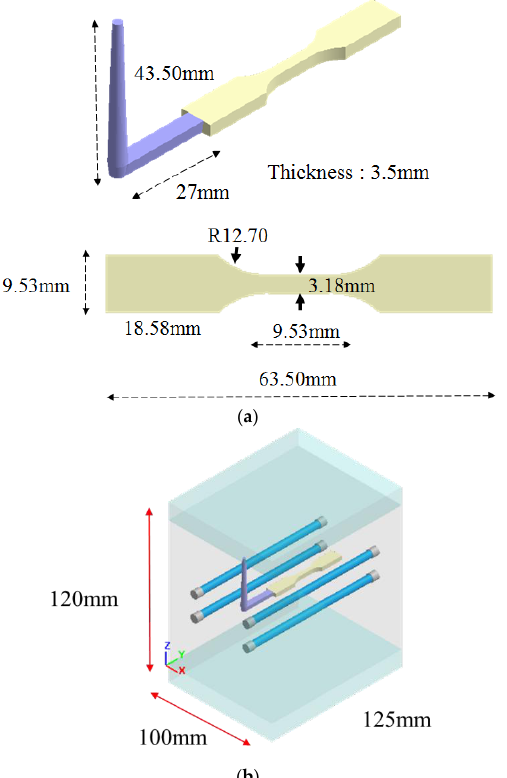
Figure 1. ( a ) Geometrical model and dimensions and ( b ) mold base and cooling channel layout. Table 1. Materials utilized in this study.